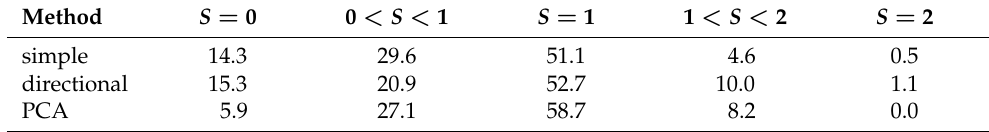
Table 1. Summary of performance identification. Number given in percent of total sample size of